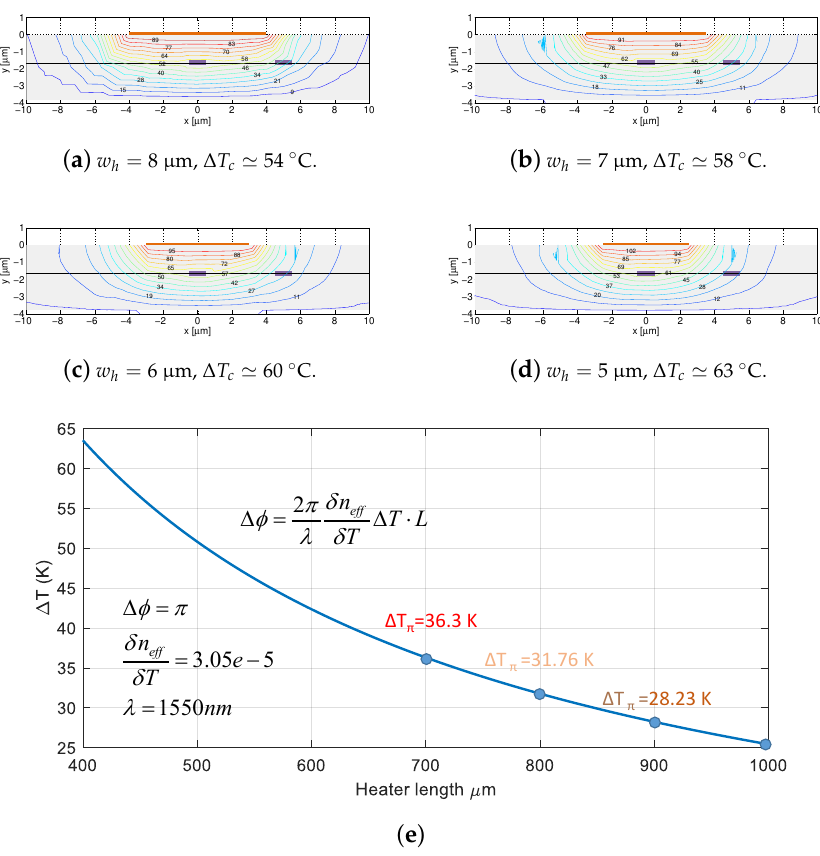
Figure 7. Waveguide cross-section with heater on top, and adjacent waveguide at a distance of 5 µ m, with temperature gradient distribution overlaid. A dotted line is drawn from left to right crossing the core of the waveguides at half their height. Four different heater widths are shown ( a – d ), for the same heater length ( L h = 270 µ m). The contours are simulated for the same heater power consumption (same amount of heat generated), showing the temperature gradient is larger for narrow heaters. Panel ( e ) shows simulation results of temperature required for a π phase shift vs. heater length. Abbreviations employed in the figure: w h heater width; ∆ φ , optical phase change; ∆ T c temperature change in the waveguide core; δ n ef f change in the effective index; ∆ T π temperature change causing a phase change of π .